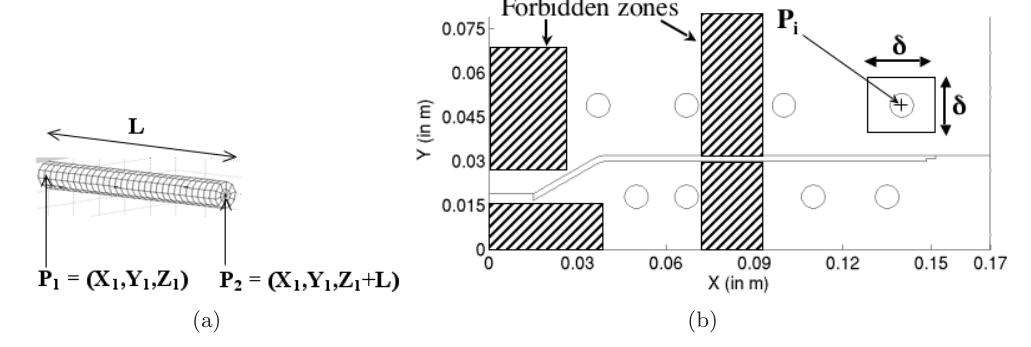
Fig. 6. Cooling channel parameters.